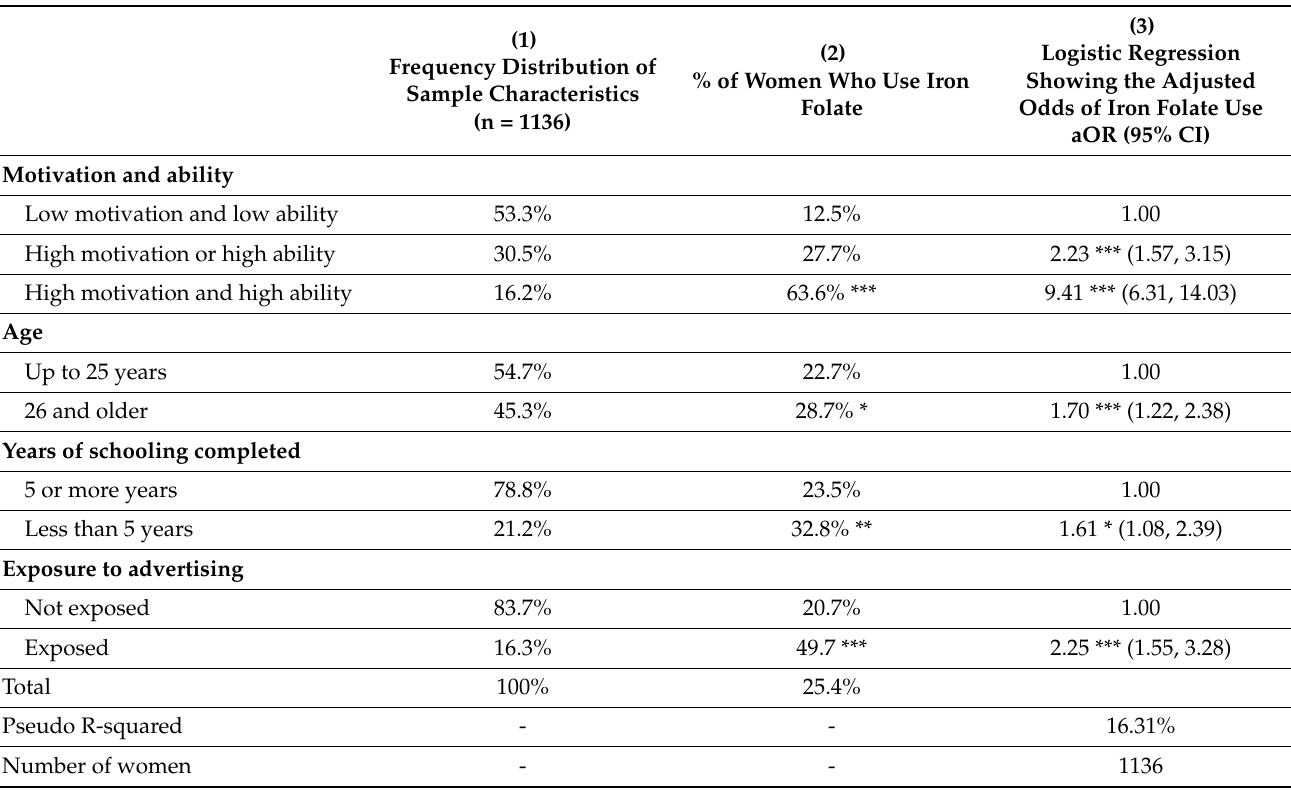
Table 5. Frequency distributions, cross tabulations and adjusted odds of odds of iron folate use among women, India.